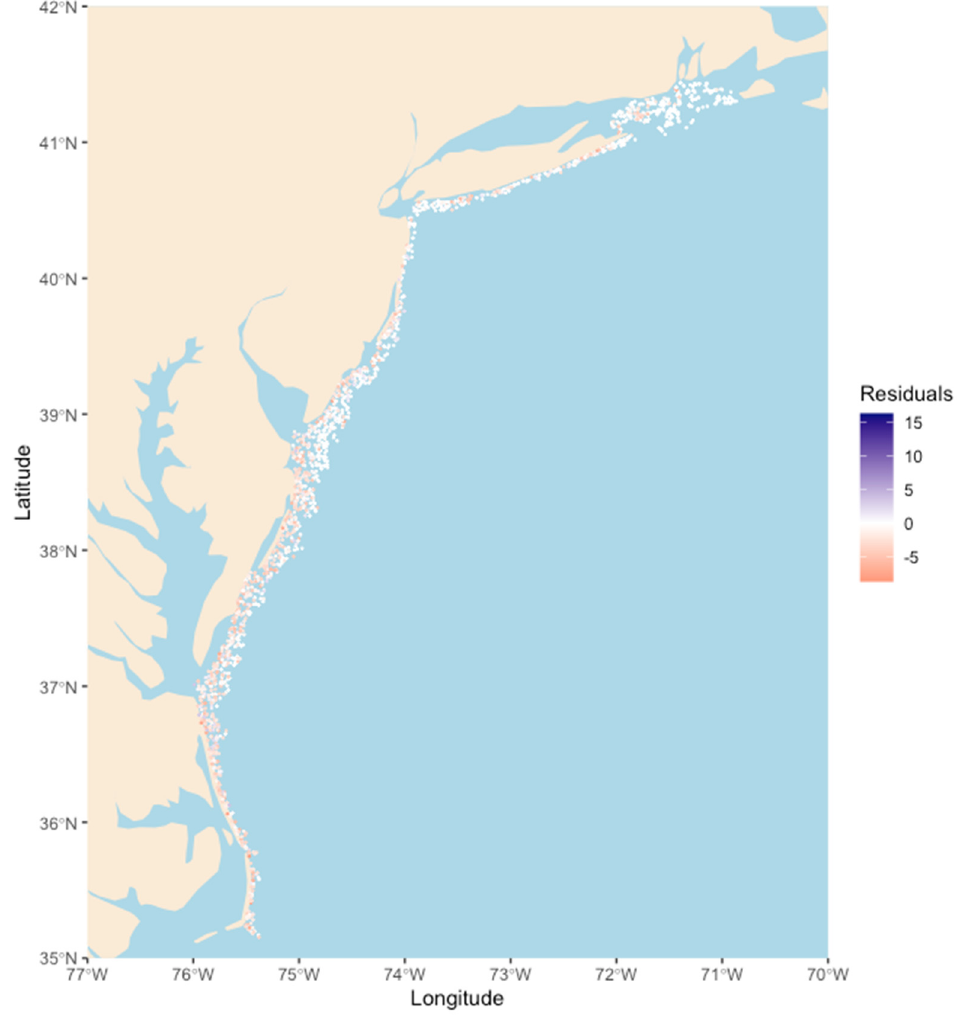
Figure A3. Map of residuals from delta spatial GAM fitted to NEAMAP weakfish survey data. Blue indicates positive, red indicates negative, and color darkness is proportional to the value of residuals.